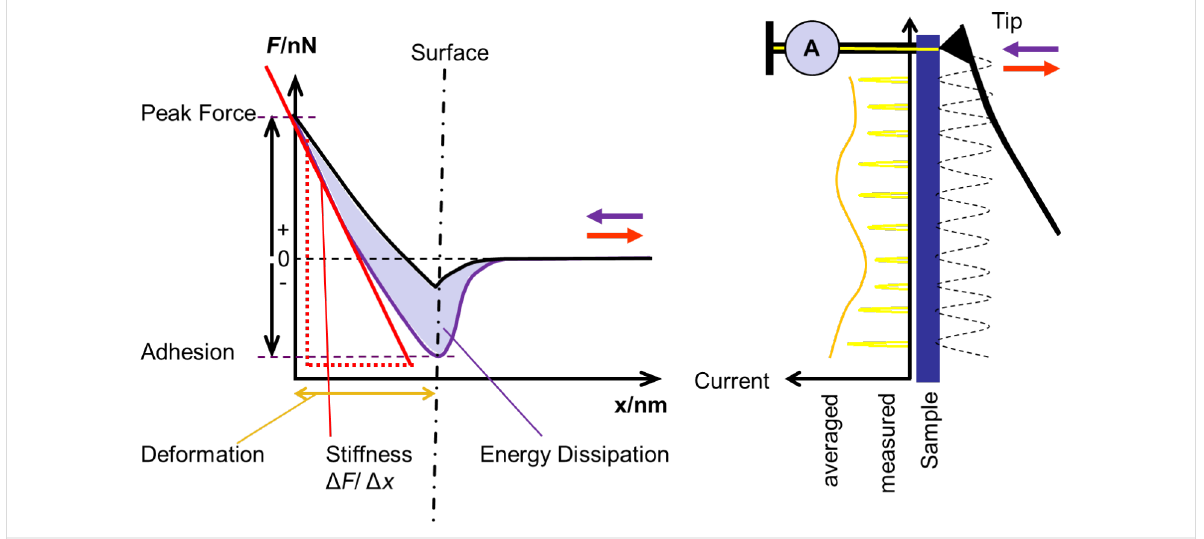
Figure 11: Force separation curve with scheme of evaluation of mechanical properties by AFM (left) and scheme of current measurement with time averaged signal (right) [36].